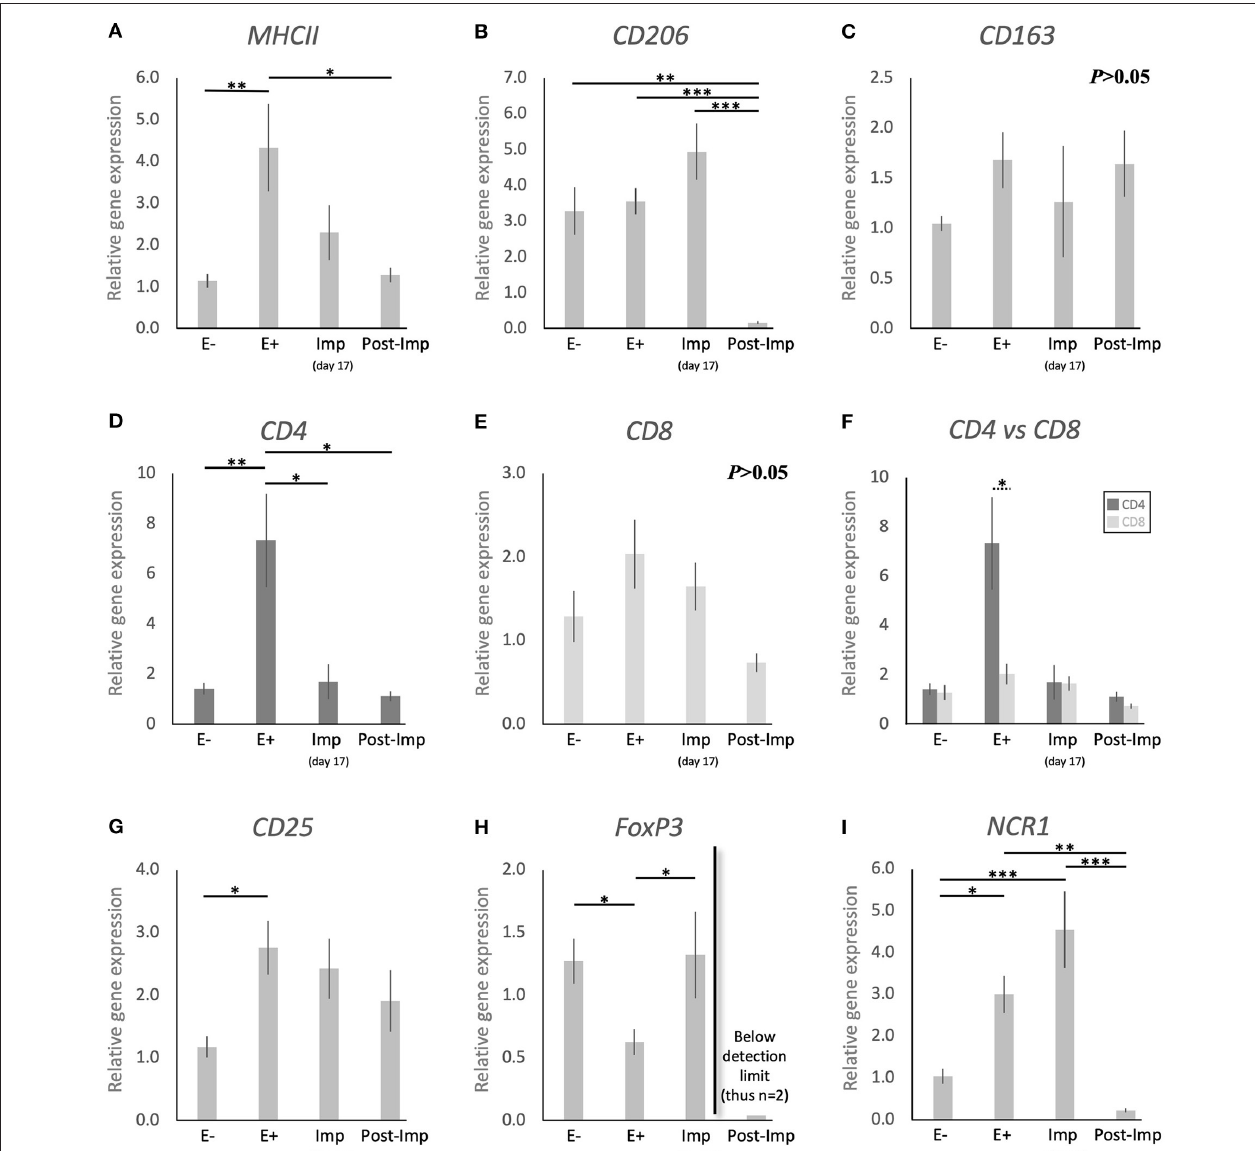
FIGURE 1 | Relative gene expression of selected immune cell markers in the canine early pregnant uterus. Relative gene expression as determined by semi-quantitative real time (TaqMan) PCR (mean ± SEM). (A–E,G–I) One-way ANOVA was applied to test the effects of time (pregnancy stage) on gene expression revealing: P = 0.005 for MHCII , P < 0.0001 for CD206, P = 0.2 for CD163, P = 0.0032 for CD4 , P = 0.06 for CD8 , P = 0.02 for CD25 , P = 0.01 for FoxP3 and P < 0.0001 for NCR1 . In the case of P < 0.05, the analysis was followed by a Tukey-Kramer multiple comparisons post-test. (F) Comparison of relative gene expression between CD4 and CD8 was evaluated by applying Student’s unpaired two-tailed t -test at each investigated stage. Bars with asterisks differ at: * P < 0.05, ** P < 0.01, *** P < 0.001.